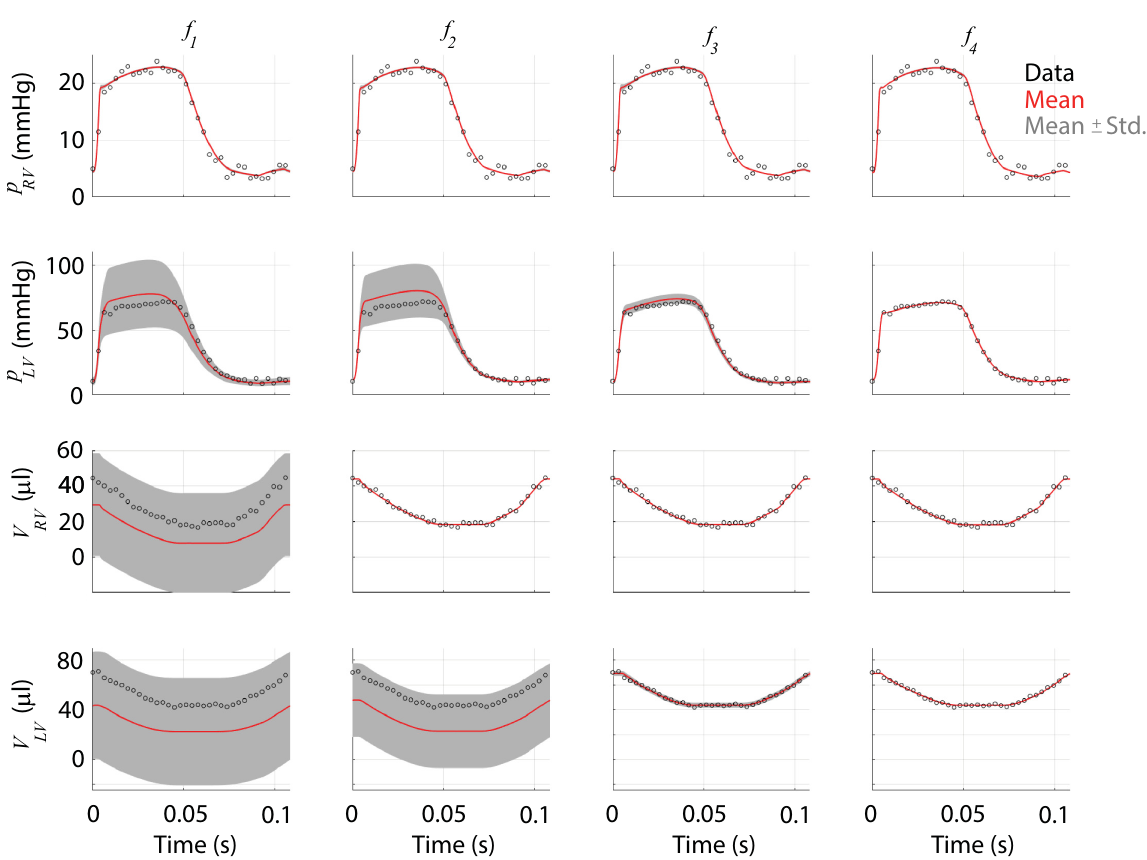
Fig 9. Output uncertainty in RV and LV pressures and volumes for each experimental design. The average model response (red) as well as ± one standard deviation (Std., gray) are provided along with the data (black circles) for each experimental design, corresponding to each column. In the first design, f 1 , only RV pressure is used in the likelihood, hence the uncertainty in RV volume and LV forecasts are substantially larger than that of the RV pressure. As more data is included, uncertainty in model forecasts is reduced. Note that differences between f 3 and f 4 are less